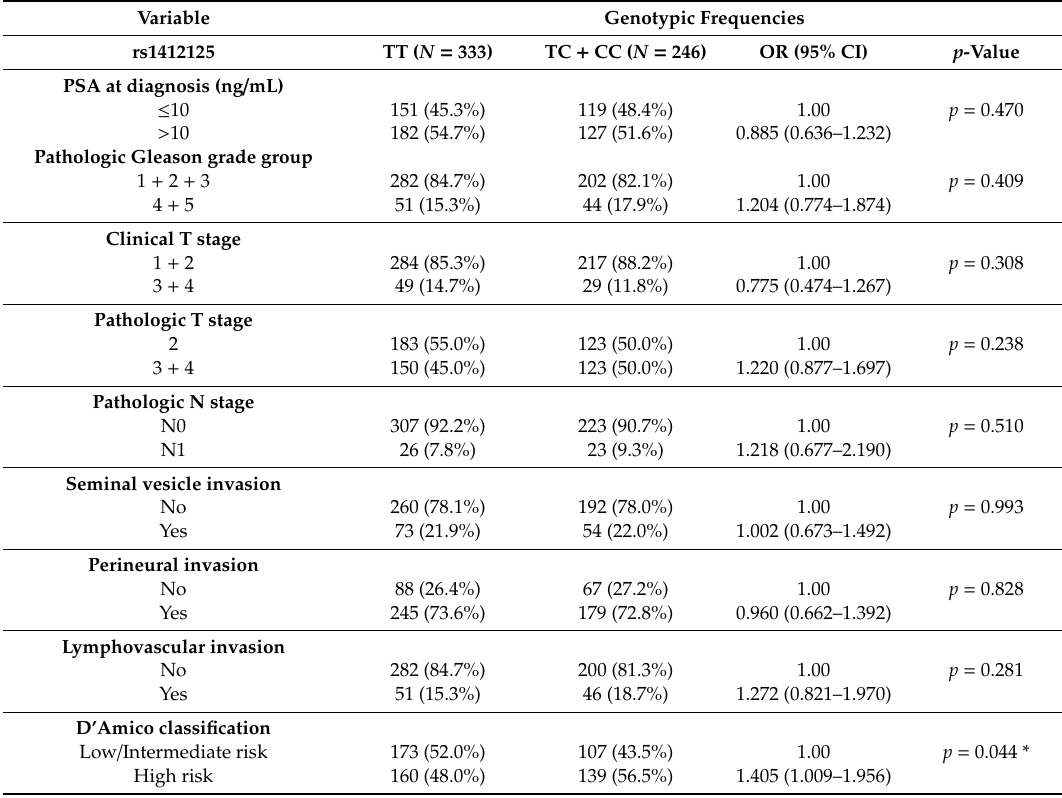
Table 3. Odds ratios (ORs) and 95% confidence intervals (CIs) of clinical status and HMGB1 rs1412125 genotypic frequencies in 579 patients with prostate cancer.